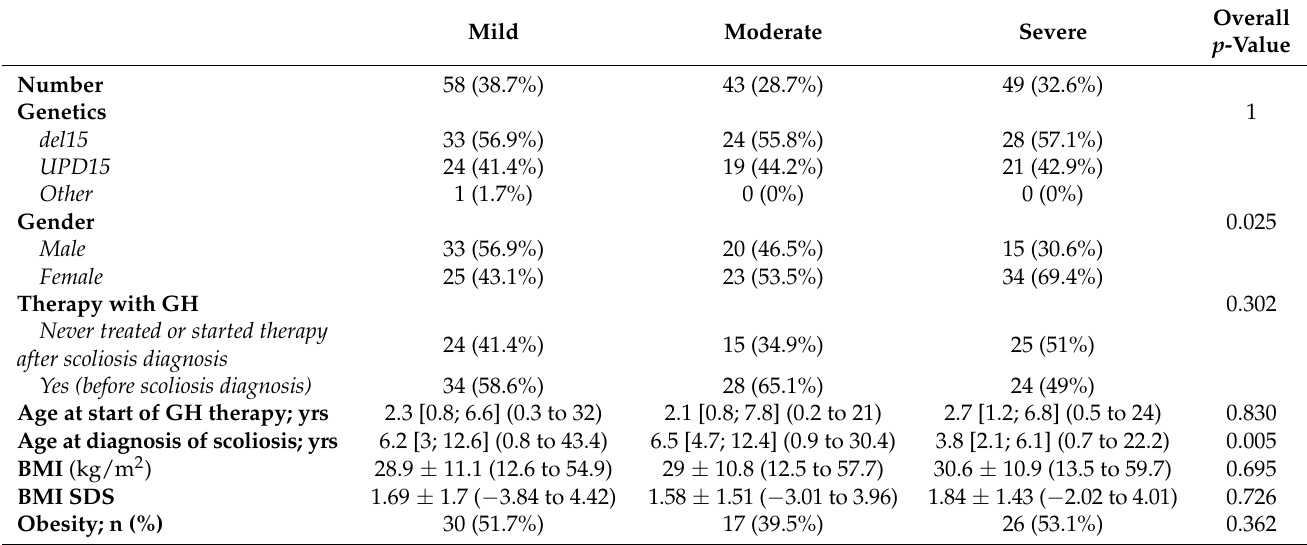
Table 4. Characteristics of 150 PWS patients stratified by severity of